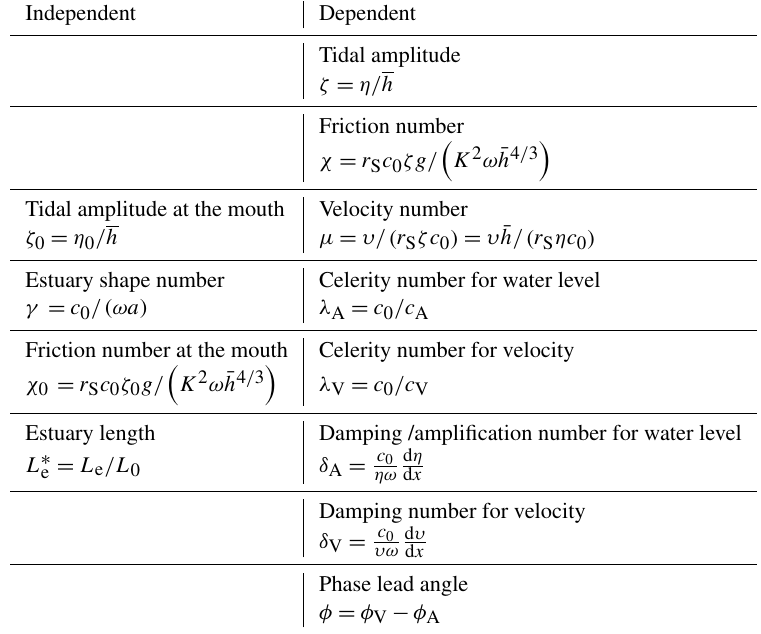
Table 1. The definitions of dimensionless